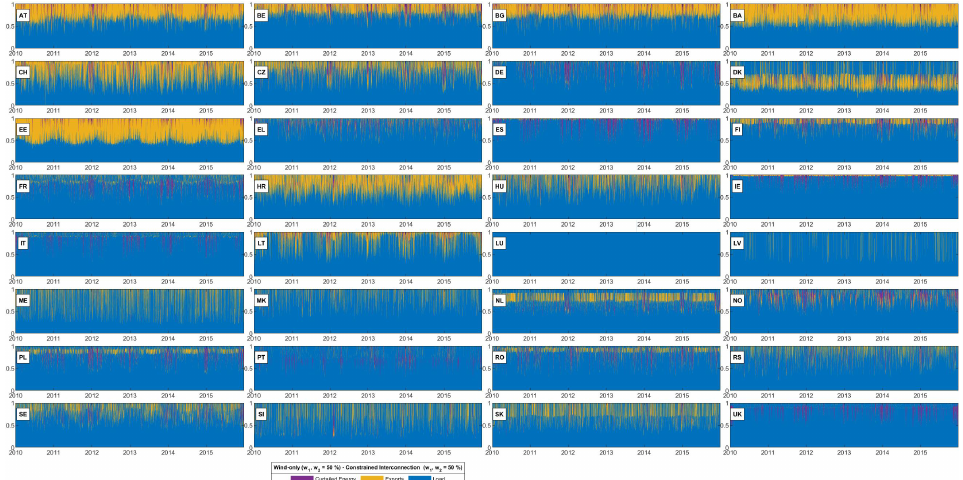
Figure 9. Right-hand side variables of the energy balance (Equation (1c)) for the case of wind power